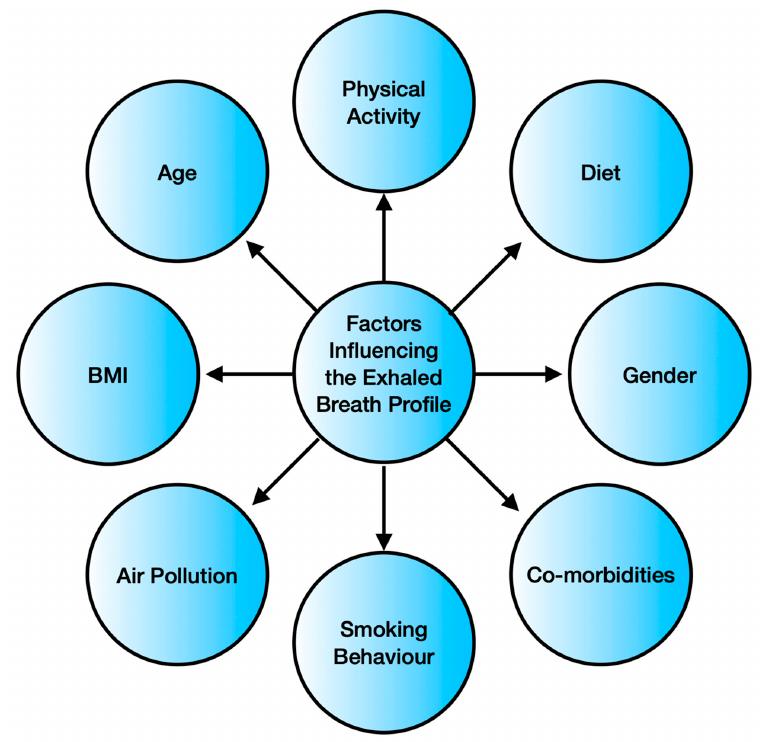
Figure 2. Factors influencing the exhaled breath profile.